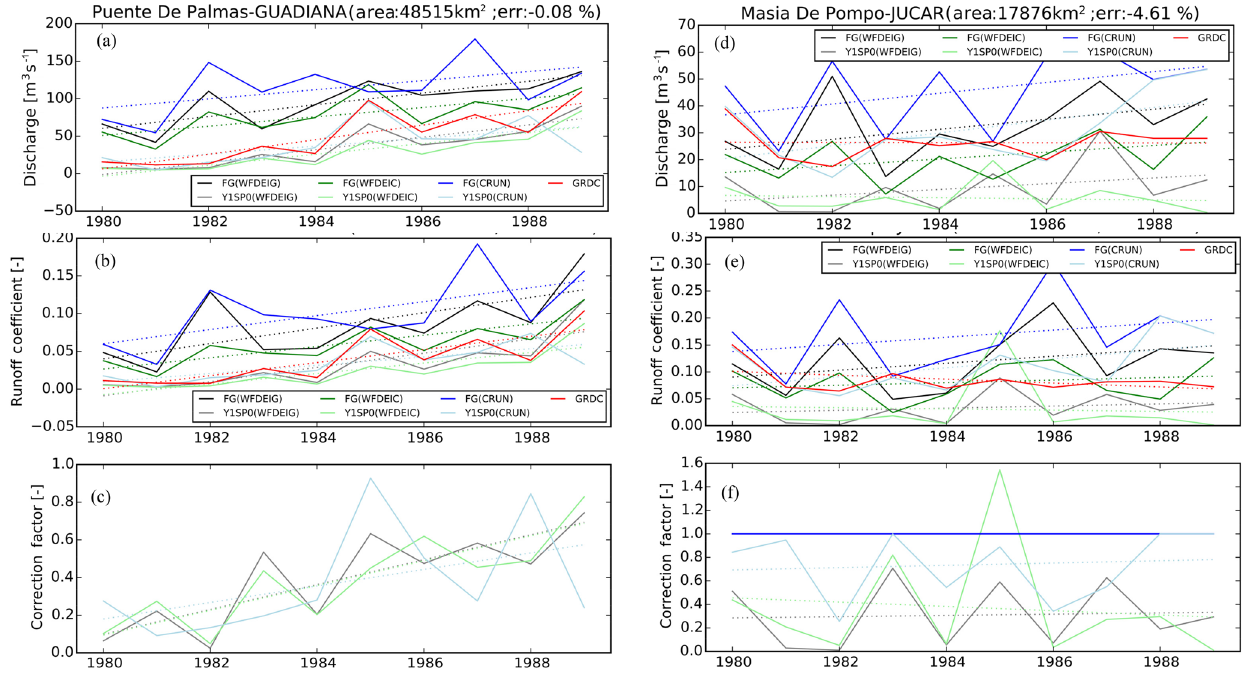
Figure 10. The optimization results by different atmospheric forcings (WFDEI-GPCC in black, WFDEI-CRU in green and CRU-NCEP in blue) over the Puente De Palmas station on the Guadiana River ( a–c , 38.88 ◦ N, − 6.97 ◦ W; 48515km 2 ) and over the Masia De Pompo station on the Júcar River ( d–f , 39.15 ◦ N, − 0.65 ◦ W; 17876km 2 ) : (a, d) annual river discharges; (b, e) runoff coefficient; (c, f) optimized correction factor x for the simulated/assimilated river discharge (First Guess in dark color, Y1SP0 in light color) with respect to GRDC observations (in red) from 1980 to